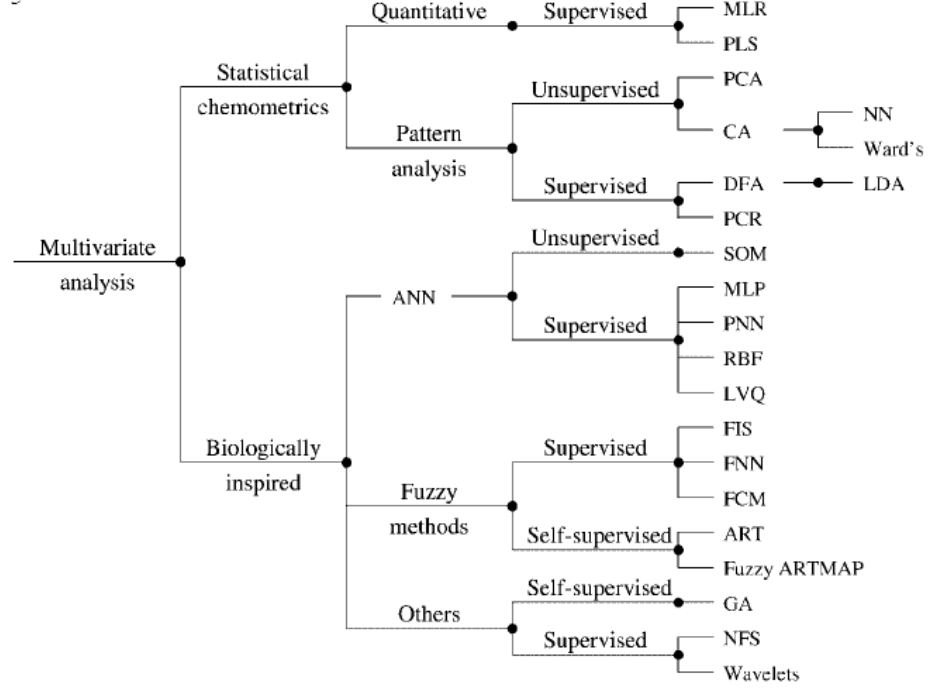
Figure 3. Classification scheme of the multivariate pattern analysis techniques applied to EN data. MLR (Multiple linear regression), PLS (Partial Least Square), PCA (Principles Component Analysis), CA (Cluster Analysis), DFA (Discrimination Functional Analysis), PCR (Principles Component Regression), SOM (Self Organizing Maps), MLP (Multilayer Perceptron), RBF (Radial Basis Function),… for more abbreviations, the reader is referred to Pearce et al.